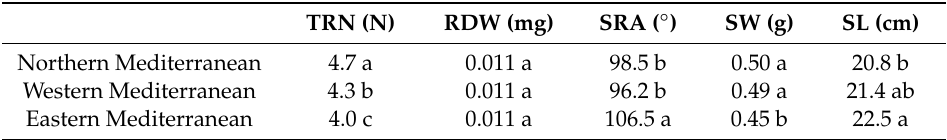
Table 4. Means comparison of seminal root traits measured in a set of 55 Mediterranean wheat landraces structured into three genetic subpopulations [23] with q > 0.8. Means within columns with di ff erent letters are significantly di ff erent at P < 0.05 following a Tukey test.